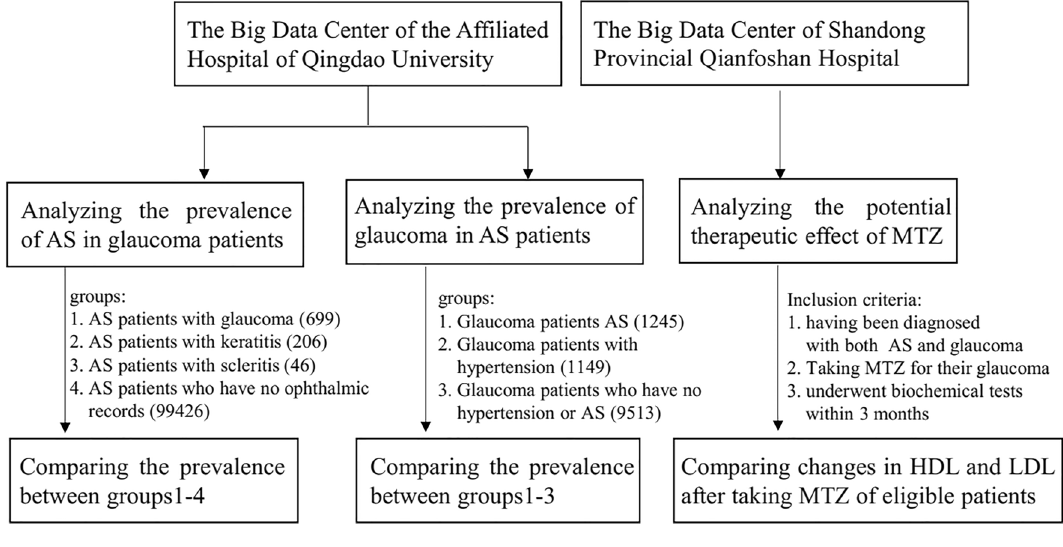
Figure 1. Flow chart for study